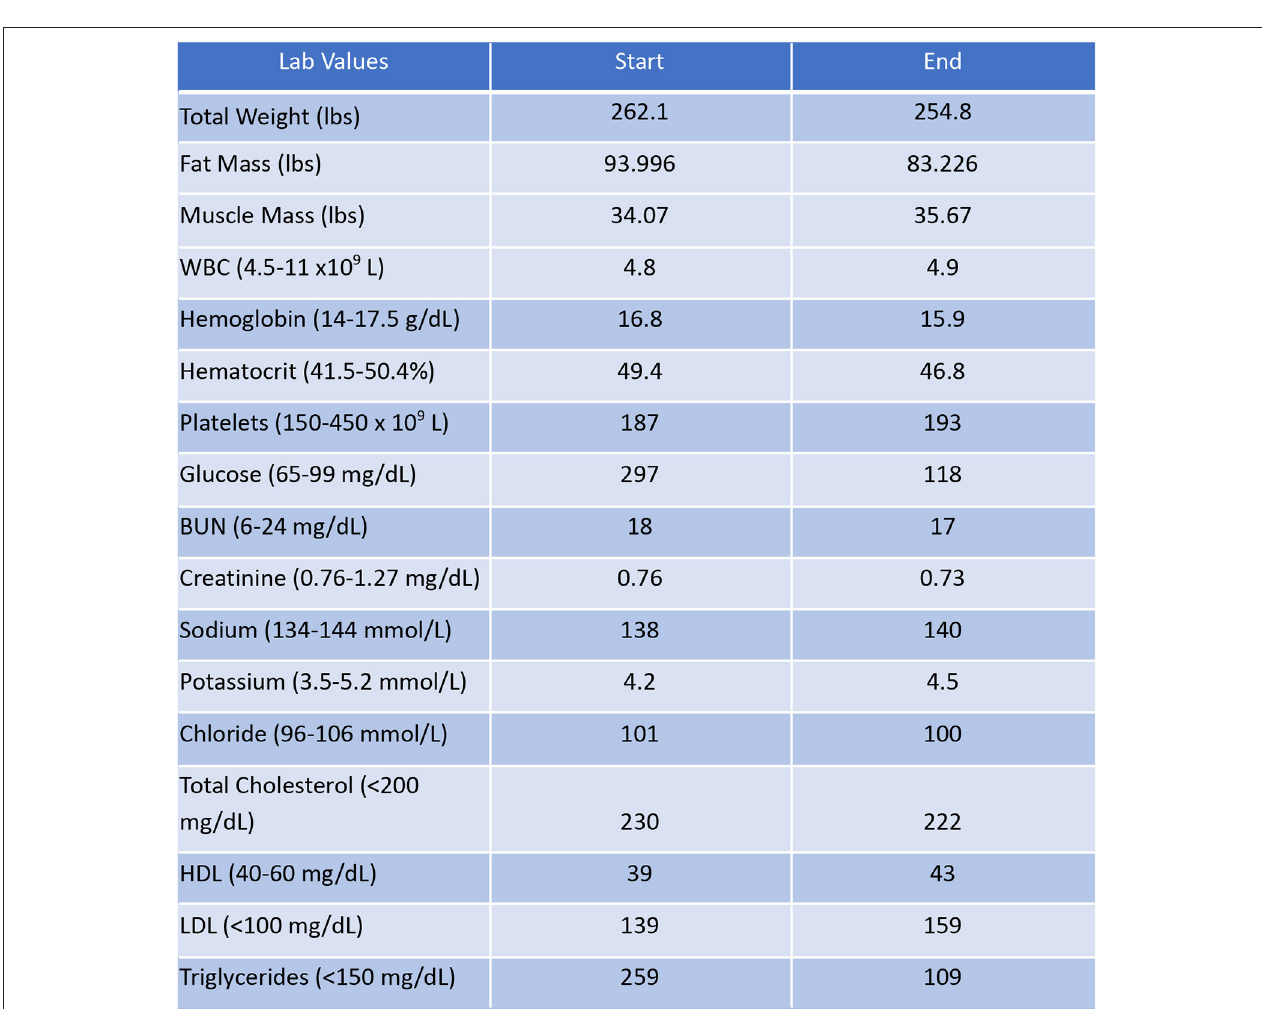
FIGURE 6 | Lab values of Patient #2 at the start and the end of the program.